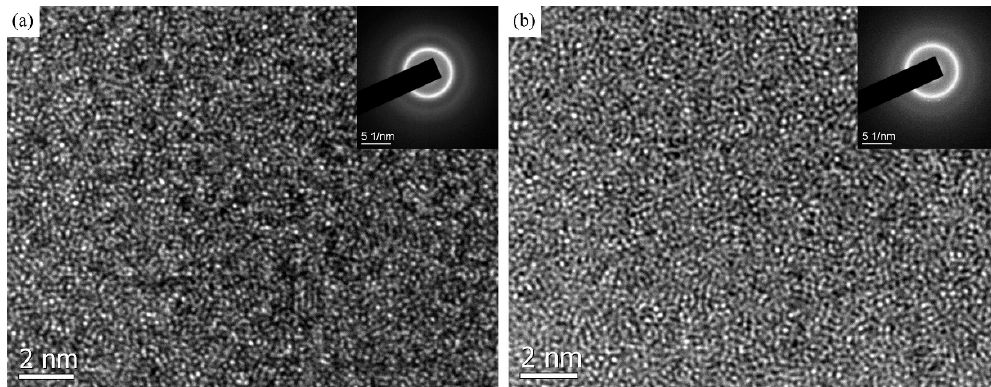
Figure 1. High-resolution transmission electron microscopy images and the corresponding selected area electron diffraction patterns of Vit105 samples ( a ) as-cast and ( b ) 650 K–30 min annealed.